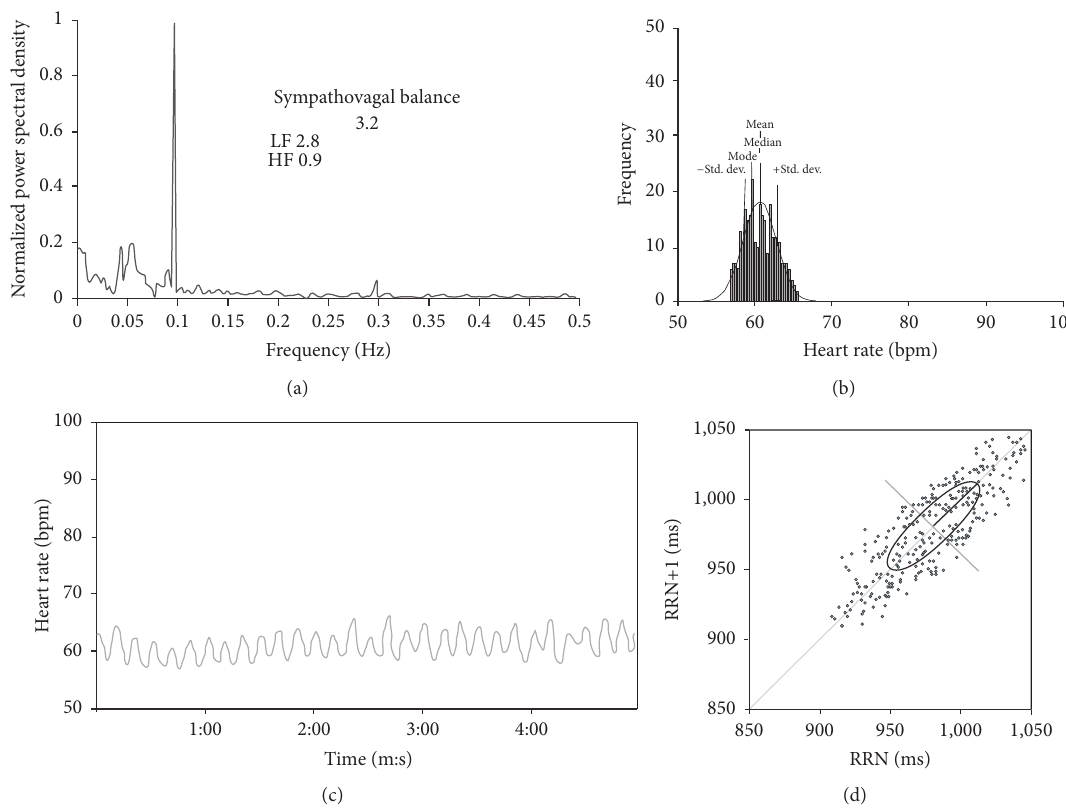
Figure 4: HRV during rhythmic breathing. (a) The total Fourier spectrum, (b) the histogram, (c) the tachogram, and (d) the Poincar´e plot. In (a), the sympathovagal balance is included (SVB = 3.27 versus 1.83 ± 0.5 in controls); the total power of LF was 2.8 versus 4.3 ± 2.4 in controls, and the total power of HF was 0.9 versus 2.4 ± 1.2 in controls. Although some respiratory driving is present, the magnitude of the driving is abnormally